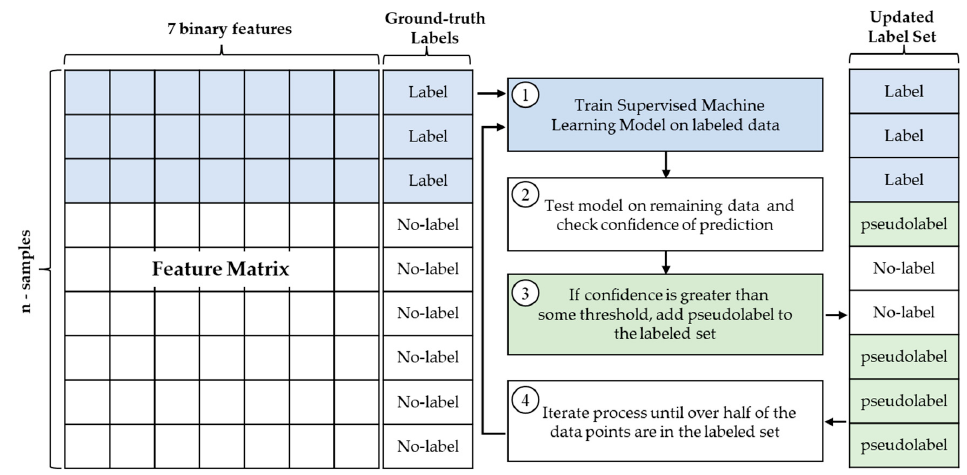
Figure 4. Semi-supervised self-training algorithm.